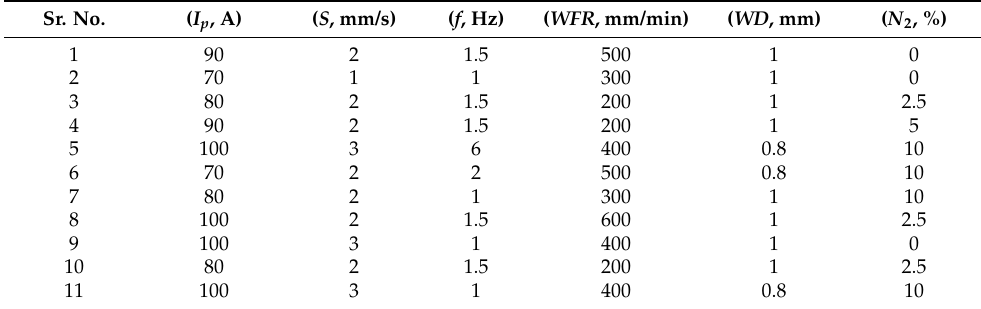
Figure 6. Comparison of stress concentration factors at the crown and root of the welds calculated using different methods. Table 5. Parameters used for the welds made in Figure